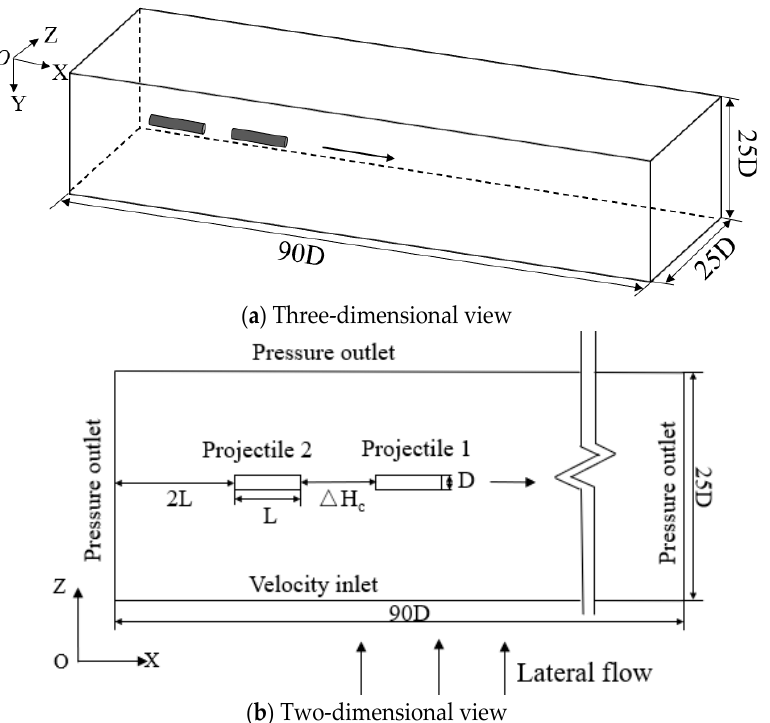
Figure 3. Schematic diagram of the computational domain and boundary conditions of the tandem projectiles.